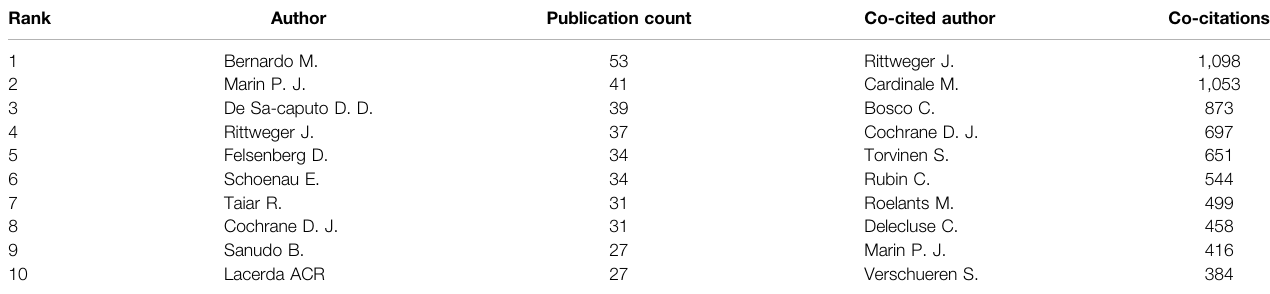
TABLE 4 | Top 10 productive authors and co-cited authors in the WBVT study.